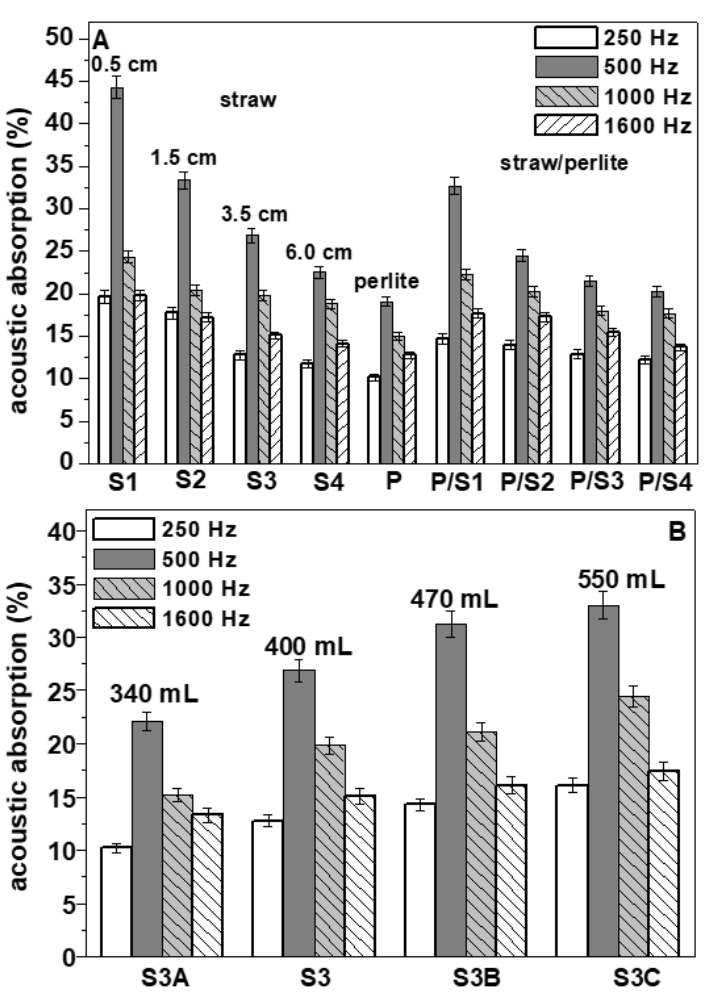
Figure 7. ( A ) Acoustic absorption of the specimens with the same volume of aggregates (400 mL). ( B ) Acoustic absorption of the S3 specimens with different volume of aggregates.